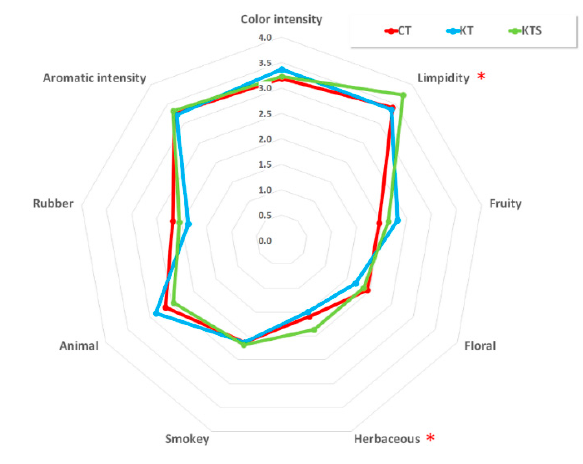
Figure 3. Sensory profile of red wines spiked with 1500 µ g / L ethyl phenol and 500 µ g / L ethyl guaiacol after 7 days treatments with chitosan. CT: untreated; KT: solid chitosan; KTS: dissolved chitosan. * Indicates significant differences according to Tukey’s test ( p < 0.05). n = 22.